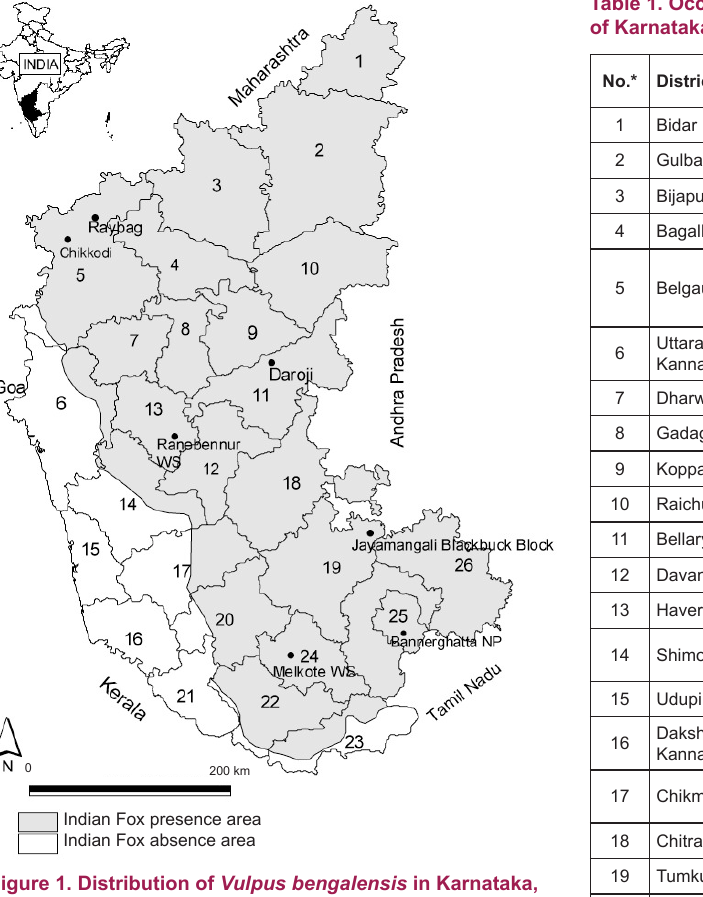
Figure 1. Distribution of Vulpus bengalensis in Karnataka, India. Numbers inside the figure indicate revenue districts (see Table 1)